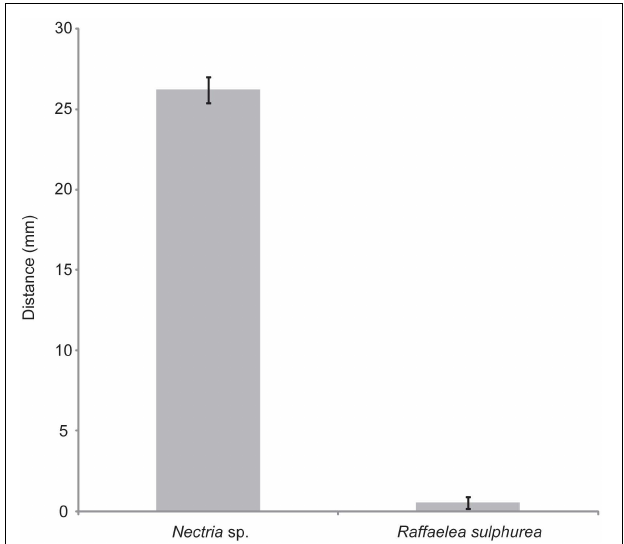
FIGURE 5 | Plate bioassays of S. griseus XylebKG-1 versus Nectria sp. and R. sulphurea. See methods for assay conditions and media used. Average values are shown from 29 and 30 trials ( Nectria sp. and R. sulphurea , respectively), with error bars representing standard error.